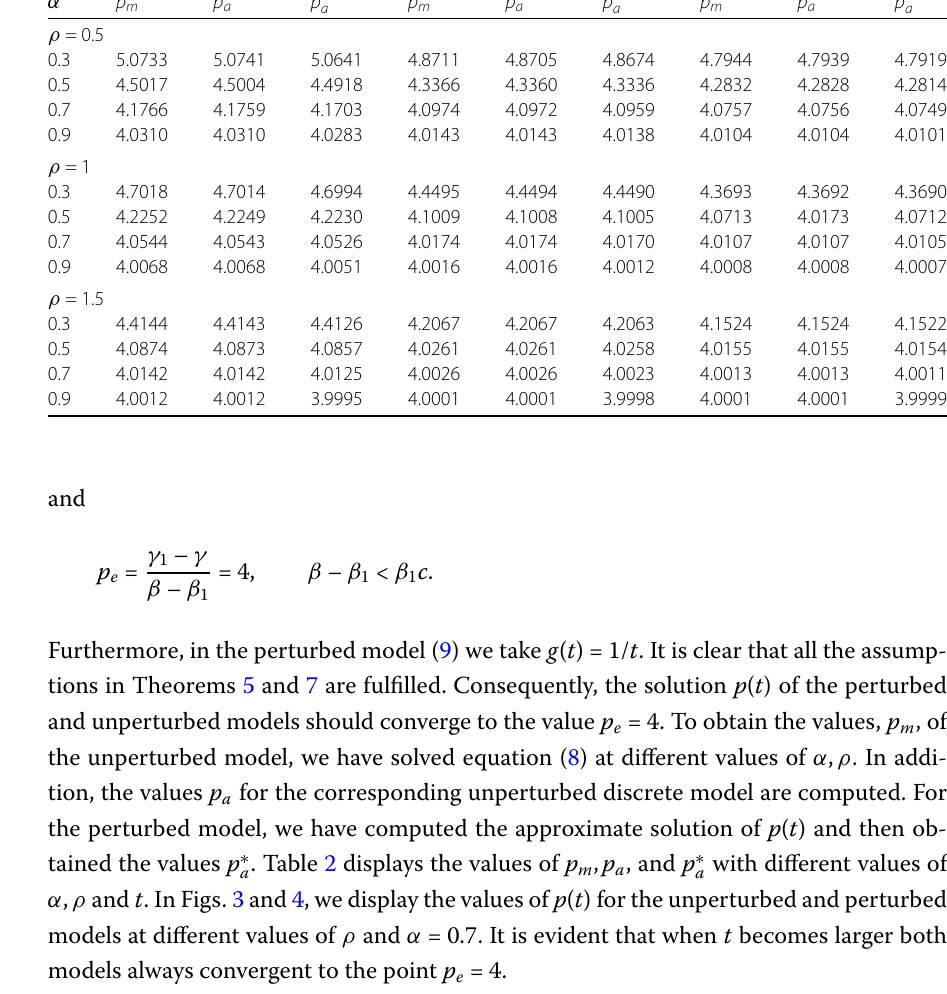
Table 2 The values of p ( t ) for the unperturbed and perturbed model of Example 2